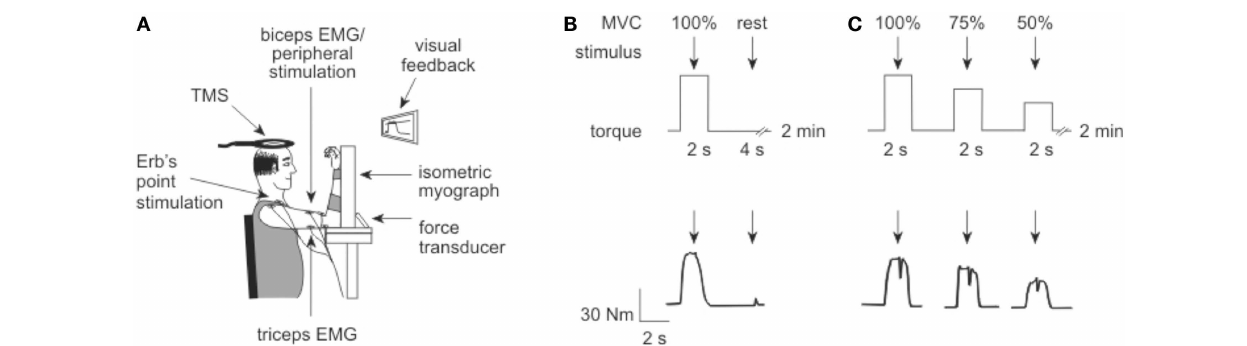
FIGURE 1 | Experiment set up . (A) Elbow flexion torque was recorded with an isometric myograph. Electrical stimulation was delivered to Erb’s point and the motor nerve of biceps, while transcranial magnetic stimulation (TMS) was delivered over the motor cortex. (B) To measure voluntary activation in the first protocol, electrical stimuli (arrows) were delivered to the motor point of